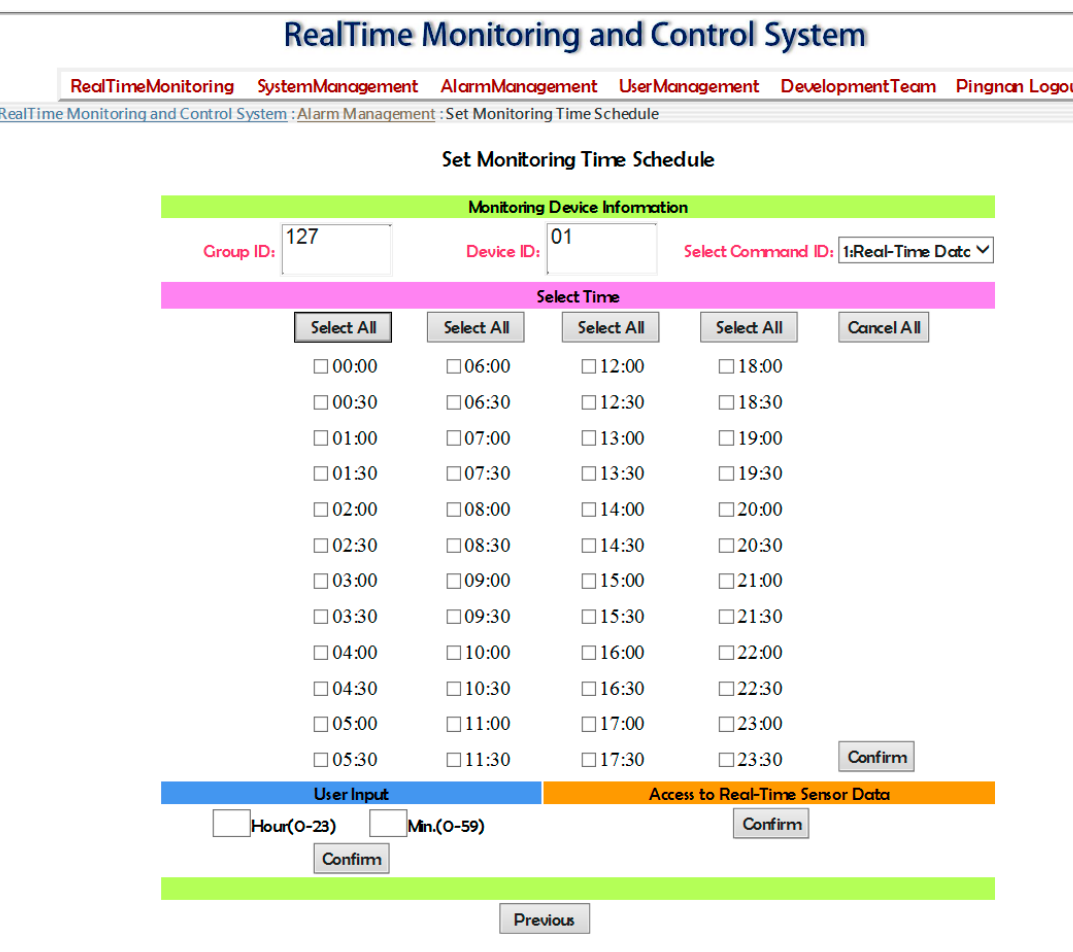
Figure 15. Control interface for managing sensor timings.